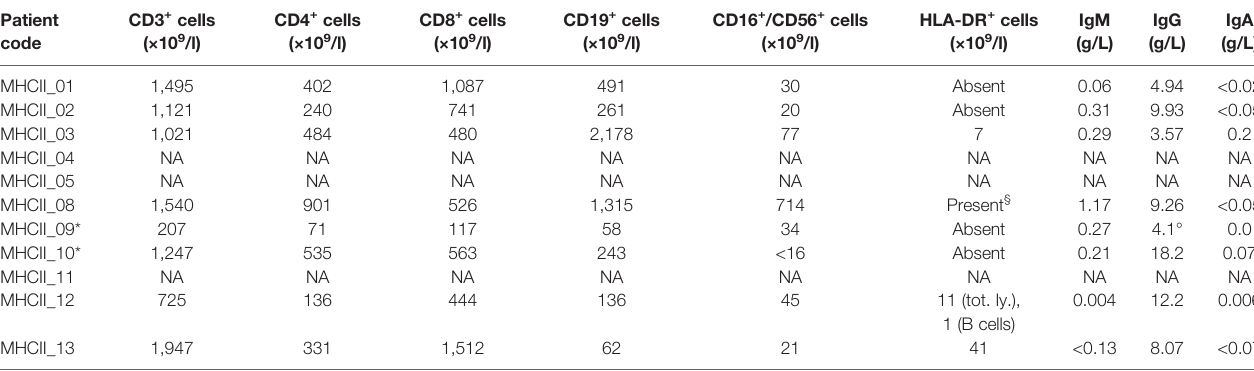
TABLE 3 | Immunophenotype and serum Ig level in our cohort of MHCII-D patients. Patient